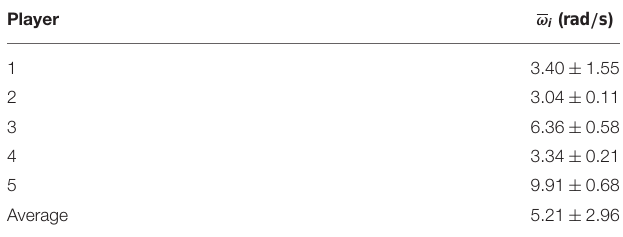
TABLE 1 | Mean individual frequencies ω i in the solo condition.